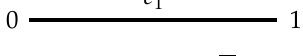
Figure 6. Graph of G ( A )